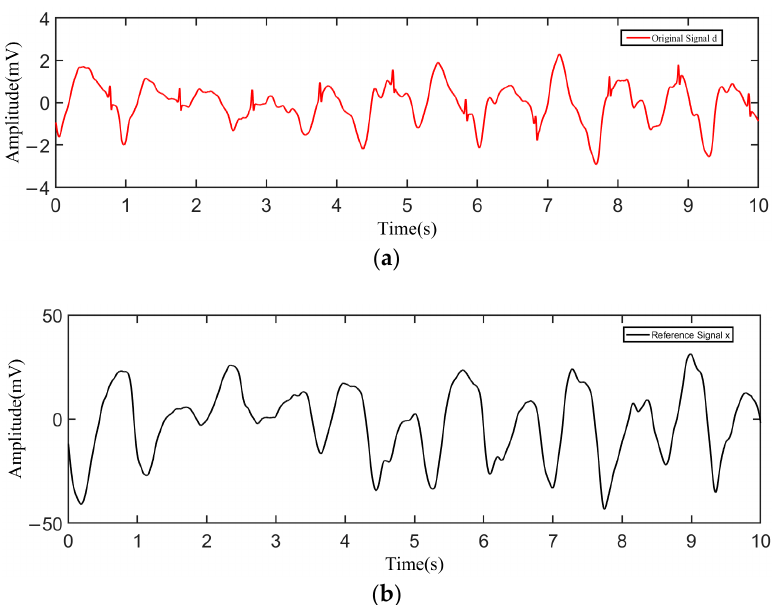
Figure 9. Original measurement results; ( a ) original signal; ( b ) reference signal.